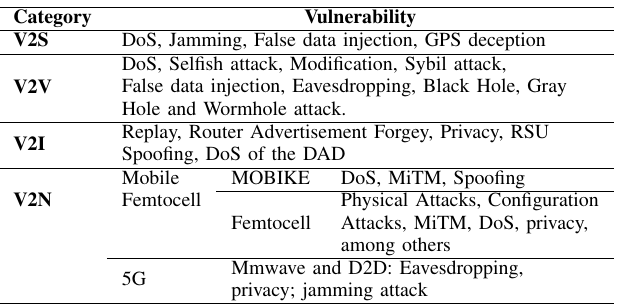
TABLE VI V ULNERABILITIES RELATED TO CONNECTED VEHICLES